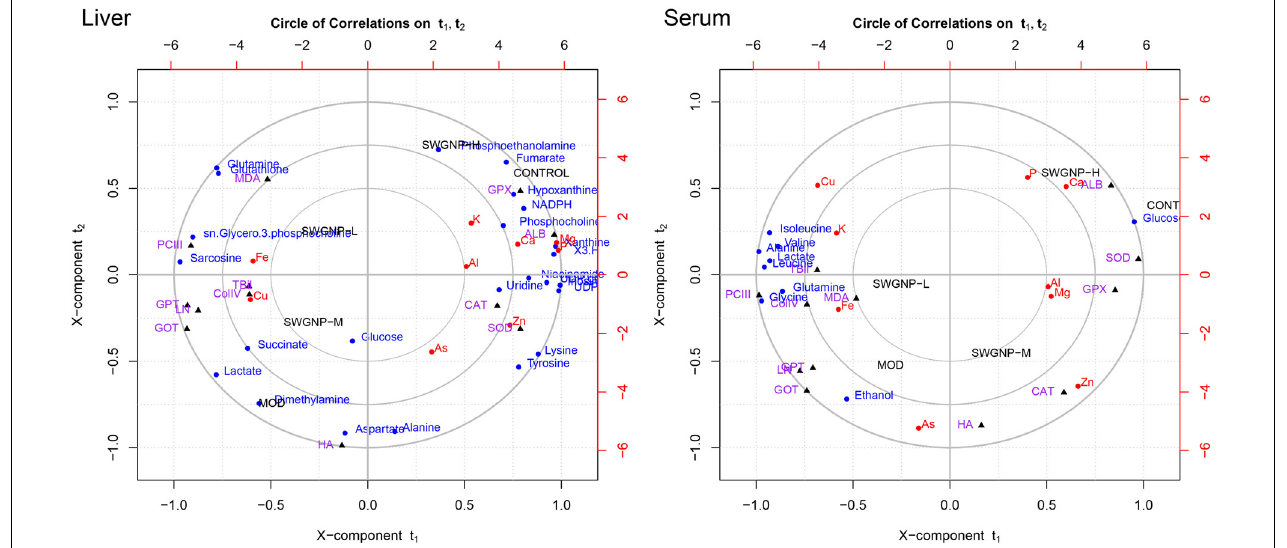
FIGURE 7 | Relationships between metabolites, elements, and biochemical parameters as revealed by canonical regression analysis using metabolites concentrations as x variables and biochemical parameters and elements contents as y variables, with three circles from inner most to outer most denoting radii of 0.50, 0.75, and 1.00, respectively.